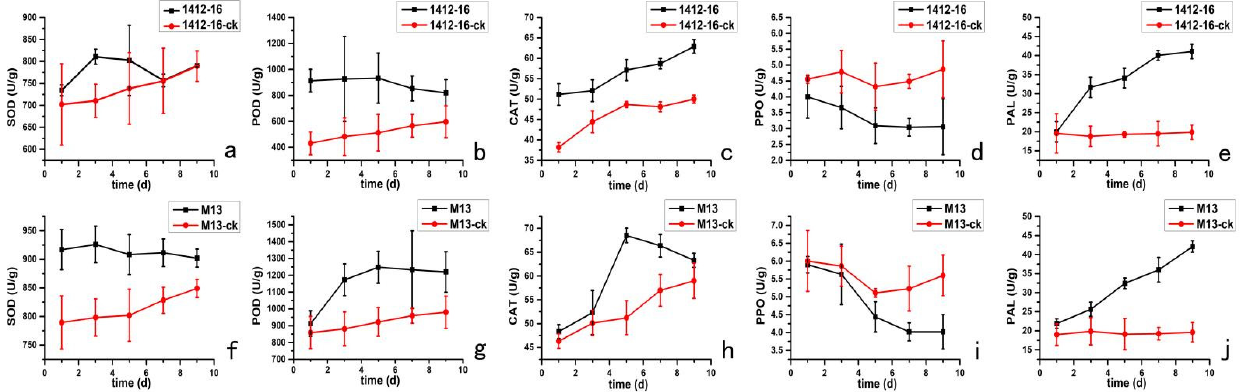
Figure 5. The impact of I. cateinannulata on defense enzyme activity in the leaves of two buckwheat varieties, F. tataricum No.M13 and 1412-16. Note: ( a,f ) Changes in SOD activity; ( b,g ): Changes in POD activity; ( c,h ) Changes in CAT activity; ( d,i ) Changes in PAL activity; ( e ,j ) Changes in PPO activity; ck: the control group.